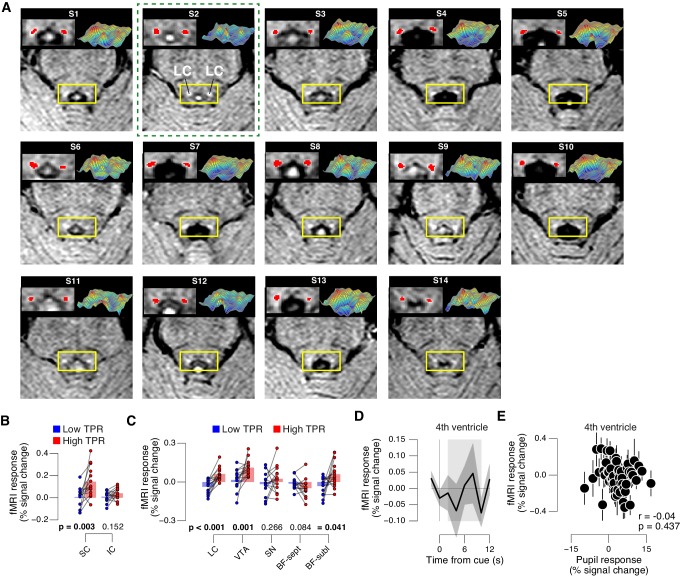
TPR-linked brainstem responses.(A) As Figure 8A for all subjects. Green outline, subject presented in Figure 8A. (B) Task-evoked responses in SC and IC, separately for low and high TPR trials. (C) As panel B, but for LC, SN, VTA, BF-sept, and BF-subl. Data correspond to Figure 8 panels B and E, but is now represented as bar graphs of task-evoked fMRI response scalar measures (see Materials and methods). (D) Remaining task-evoked fMRI response in the fourth ventricle (after RETROICOR). The fourth ventricle ROI was delineated in the TSE scan, and its response computed by averaging across all voxels covering the ventricle. Gray-shaded interval, task-evoked fMRI response measure time window. Residual signal fluctuations in the fourth ventricle were uncorrelated to task events. Shading, s.e.m. (E) Task-evoked fMRI responses in the fourth ventricle plotted against TPR. Data were binned for display (50 bins). Panels B-E: group average (N = 14). Panels B,C: data points, individual subjects; stats, permutation test.